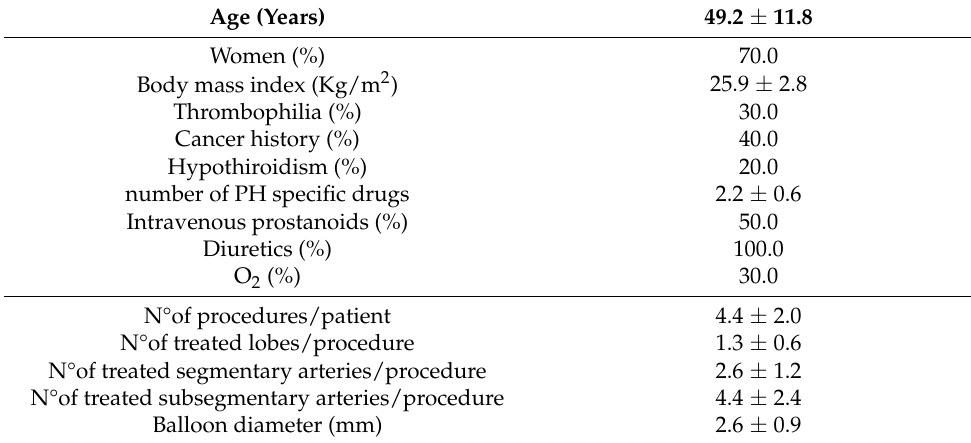
Table 1. Baseline characteristics in postsurgical patients ( n =